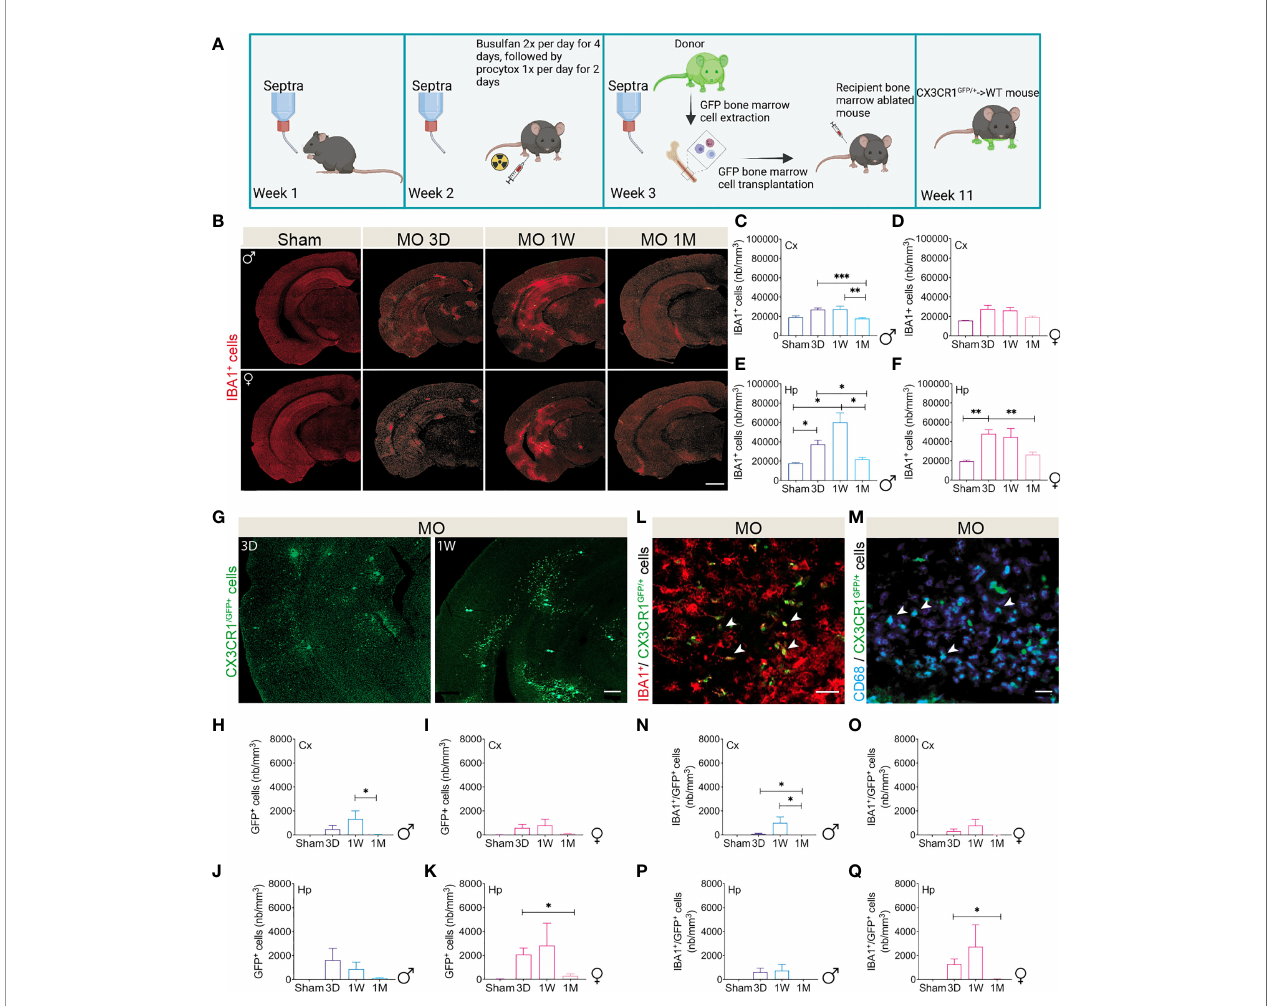
FIGURE 8 | Multifocal microinfarcts stimulate the in fi ltration of peripheral phagocytic cells into the brain. (A) A scheme illustrating the strategy used to generate CX3CR1 GFP/+ ! WT chimeric mice. WT mice were subjected to a chemotherapy regimen to ablate bone marrow-derived myeloid cells and transplanted with bone marrow cells from donor CX3CR1 GFP/+ mice in which Ly6C low CX3CR1 high cells are GFP + . Created with BioRender.com. (B) Representative fl uorescent images of IBA1 immunolabeled microglia (red) in the brain of MO-operated male and female WT mice at 3 days, 1 week and 1month post-microinfarct induction. (C) Immuno fl uorescence combined to stereological analysis indicates that the density of IBA1 + cells, increases in the cortex of MO-operated male CX3CR1 GFP/+ ! WT chimeric mice, peaking at 3 days, and remaining elevated until 1 week, and then decreases 1 month post-microinfarct induction. (D) Immuno fl uorescence combined to stereological analysis shows a similar trend in the cortex of MO-operated female CX3CR1 GFP/+ ! WT chimeric mice without reaching a statistical signi fi cance. (E) Immuno fl uorescence combined to stereological analysis indicates that the density of IBA1 + cells, increases in the hippocampus of MO-operated male CX3CR1 GFP/+ ! WT chimeric mice, peaking at 3 days, and remaining elevated until 1 week, followed by a decrease 1 month post-microinfarct induction. (F) Immuno fl uorescence combined to stereological analysis shows a similar trend in the hippocampus of MO-operated female CX3CR1 GFP/+ ! WT chimeric mice. Representative fl uorescent images show that CX3CR1 GFP/+ cells are massively recruited into the brain of MO-operated male CX3CR1 GFP/+ ! WT chimeric mice, (G) 3 days and 1 week post- microinfarct induction. Immuno fl uorescence combined to stereological analysis indicates that the number of CX3CR1 GFP/+ cells peaks in the cortex of (H) MO- operated male CX3CR1 GFP/+ ! WT chimeric mice, and to a lesser extent in (I) females, 1 week post-microinfarct induction. (J) Immuno fl uorescence combined to stereological analysis indicates that the number of CX3CR1 GFP/+ cells in the hippocampus of MO-operated male CX3CR1 GFP/+ ! WT chimeric mice progressively increases at 3 days and decreases 1 month post-microinfarct induction. (K) Immuno fl uorescence combined to stereological analysis indicates that the number of CX3CR1 GFP/+ cells in the hippocampus of MO-operated female CX3CR1 GFP/+ ! WT chimeric mice increases 1 week and decreases 1 month post-microinfarct induction. (L) A representative fl uorescent image showing the colocalization of microglia (IBA1-immunolabeled) and bone marrow-derived CX3CR1 GFP/+ cells at the lesion site. (M) A representative fl uorescent image showing expression of the phagocytic maker CD68 in bone marrow derived CX3CR1 GFP/+ cells at the lesion site. (N) Immuno fl uorescence combined to stereological analysis indicates that the density of IBA1 + /CX3CR1 GFP/+ cells increases the cortex of MO-operated male CX3CR1 GFP/+ ! WT chimeric mice 1 week and decreases 1 month post-microinfarct induction. (O) Immuno fl uorescence combined to stereological analysis outlines a similar trend in MO-operated female CX3CR1 GFP/+ ! WT chimeric mice without reaching statistical signi fi cance. Immuno fl uorescence combined to stereological analysis indicates that the density of IBA1 + /CX3CR1 GFP/+ cells in the hippocampus of (P) MO-operated male CX3CR1 GFP/+ ! WT chimeric mice remains unchanged, while (Q) it increases in females 1 week post-microinfarct induction. Data are mean ± SEM (n = 5-10 animals/group). *P < 0.05/*P < 0.01/***P < 0.001 compared to sham- and MO-operated male and female CX3CR1 GFP/+ ! WT chimeric mice at different time points (two-tailed unpaired t-test). Scale bar = 500 µm (B) and 150 µm (G, L, M)